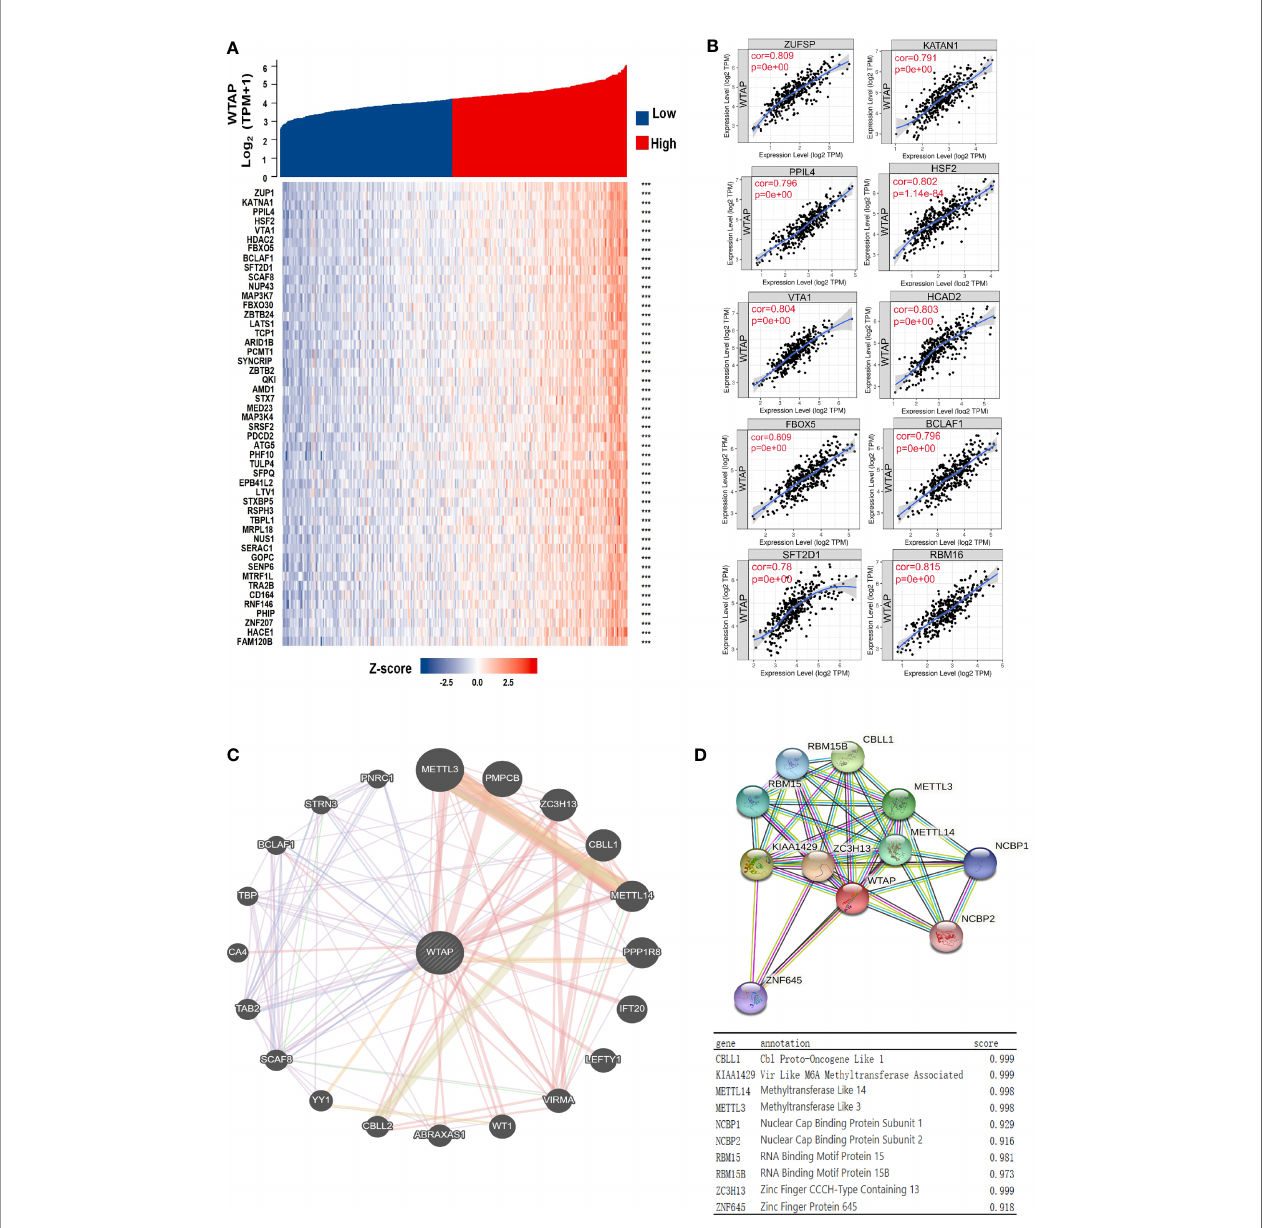
FIGURE 3 | (A) Heatmap showing the top 50 genes most strongly related to WTAP. (B) Top 10 genes co-expressed with WTAP in HCC samples. (C, D) Proteins interacting with WTAP in HCC tissues and their co-expression scores. *** P <